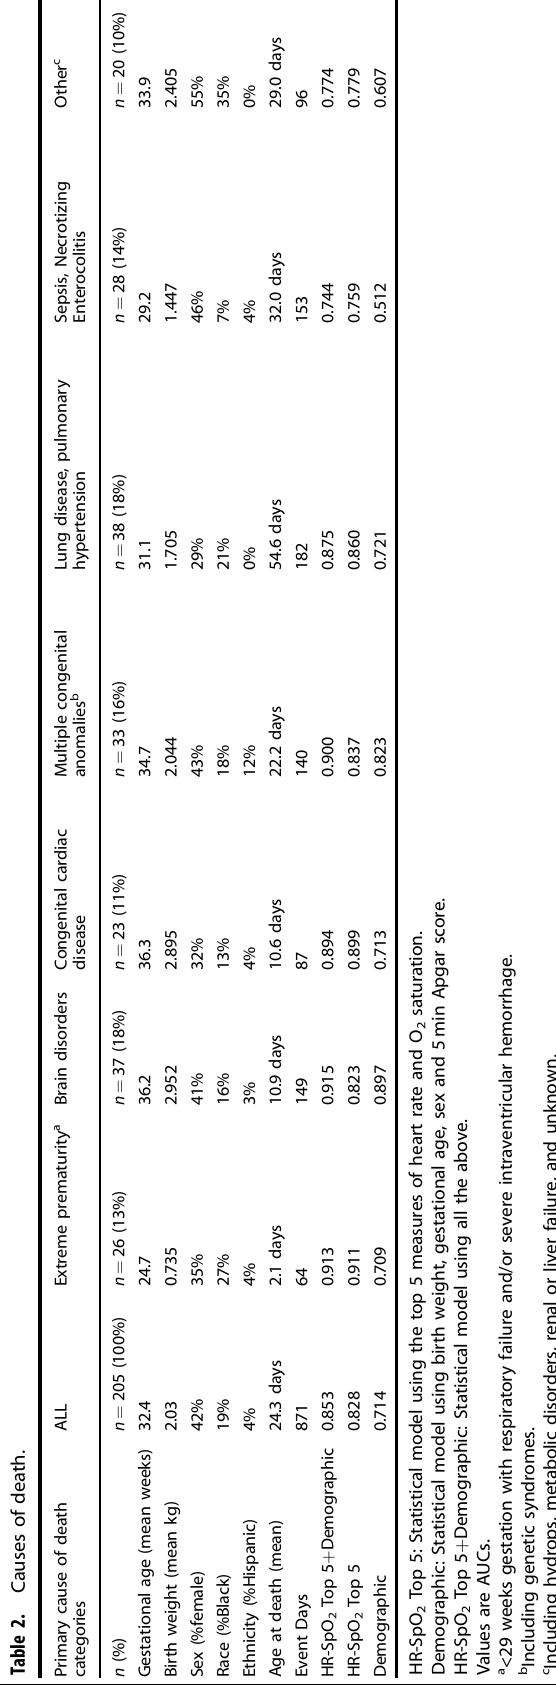
Table 1. Demographics of the patient population. Cohort